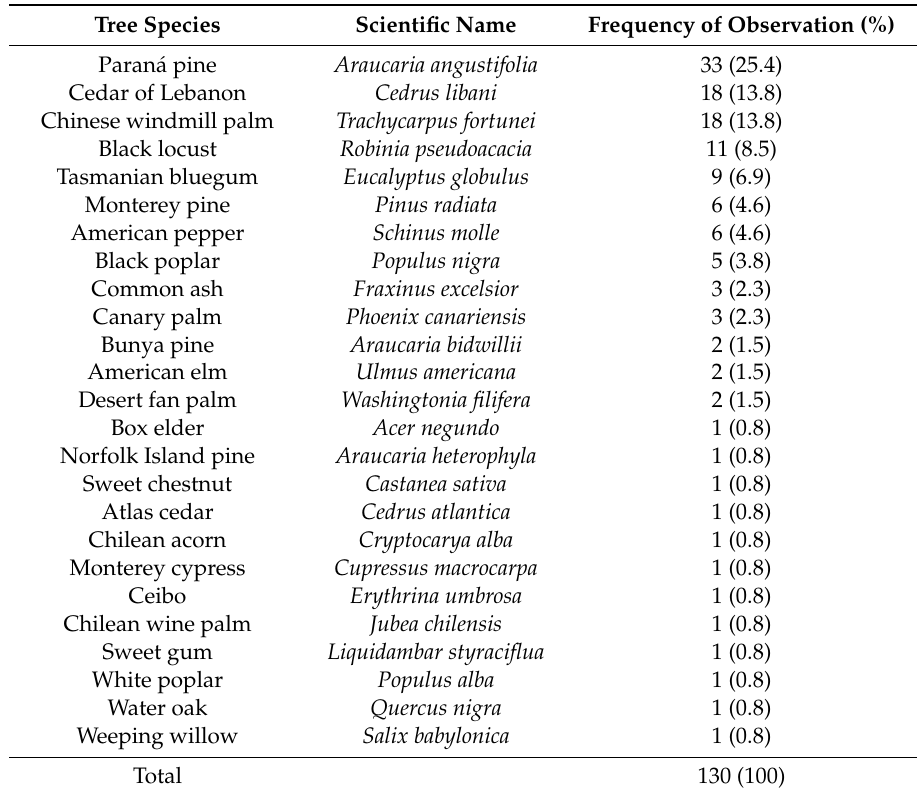
Table 1. Tree species having monk parakeets’ nests, and where observations of interactions with other bird species were registered during Austral springs (15 August–21 December) of 2017 and 2018. Tree Species Scientific